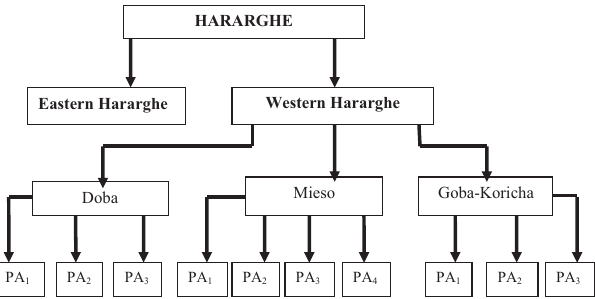
Figure 1. The sample frame